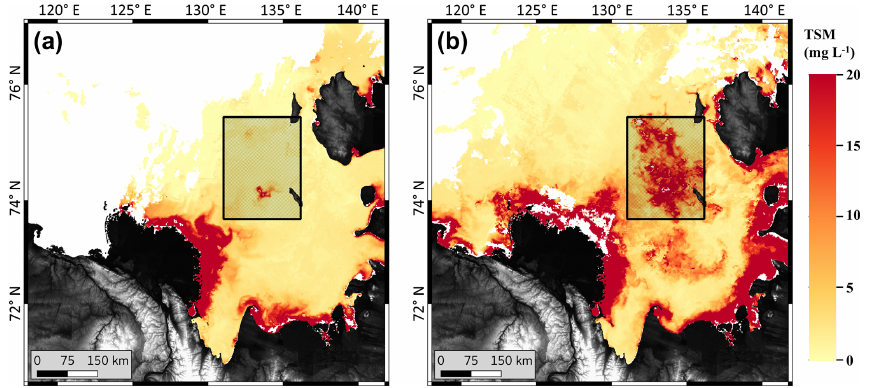
Figure 9. ONNS-derived TSM concentration for satellite mosaics from (a) August 2010 and (b) September 2010. The shallow water area is highlighted by the black square.